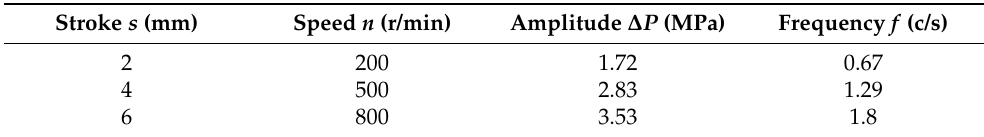
Table 2. Settings for the stroke and speed of servo stamping machine and the pulsation parameters of the amplitude and